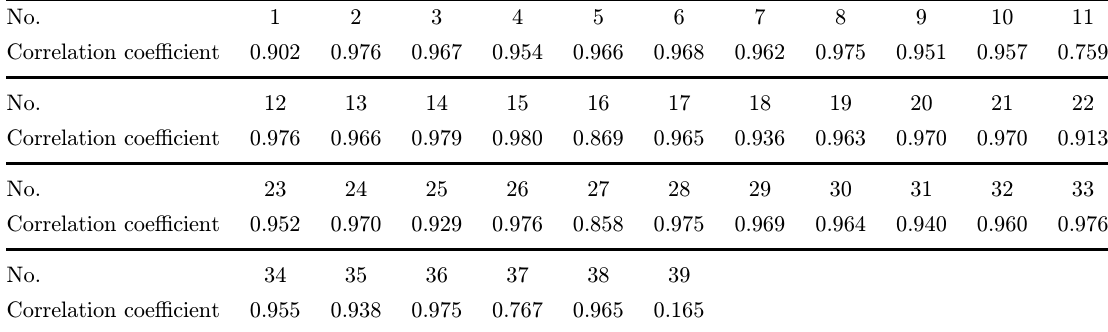
Table 3. Nifedipine near-infrared spectral images correlation coe±cient.